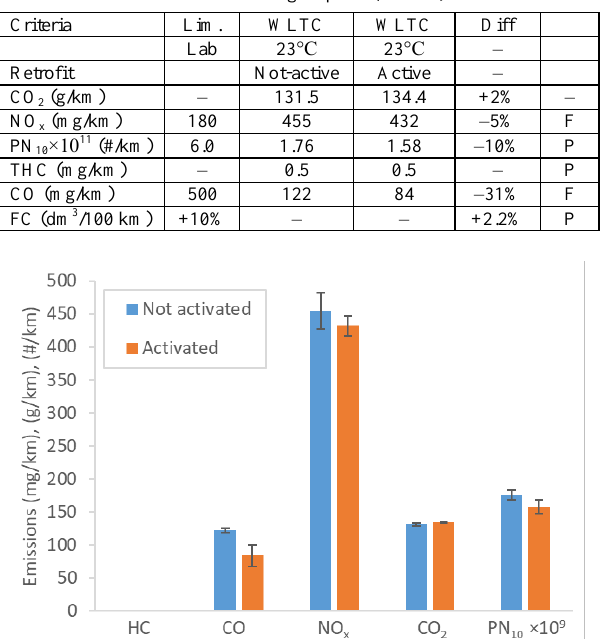
Fig. 1. Comparison of cold WLTC at 23 ° C emissions with the retrofitted activated or not. Error bars show max-min of 2–3 repetitions